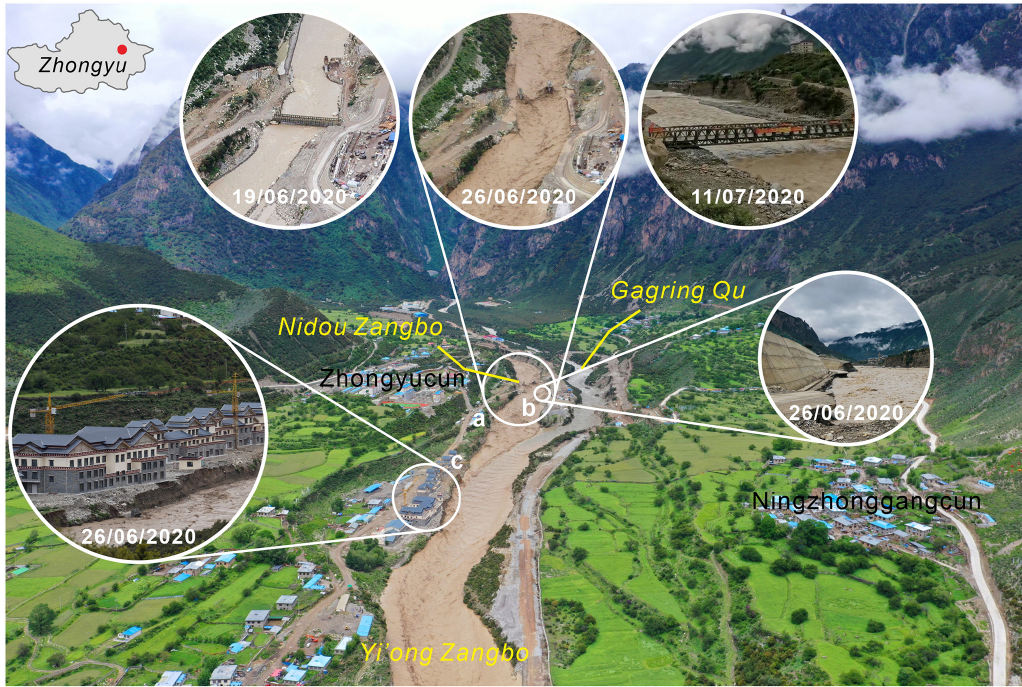
Figure 12. Examples of GLOF damage to downstream infrastructure and buildings at the confluence of Nidou Zangbo and Gagring Qu. Background aerial photo by Heng Li taken on 26 June 2020. (a) Comparison of the bridge connecting Zhongyucun and Ningzhonggangcun before, during (photos: Heng Li), and after the GLOF (rebuilt, photo: Kejun Ma). (b) Destroyed roads (photo: Heng Li). (c) Affected buildings at risk (photo: Heng